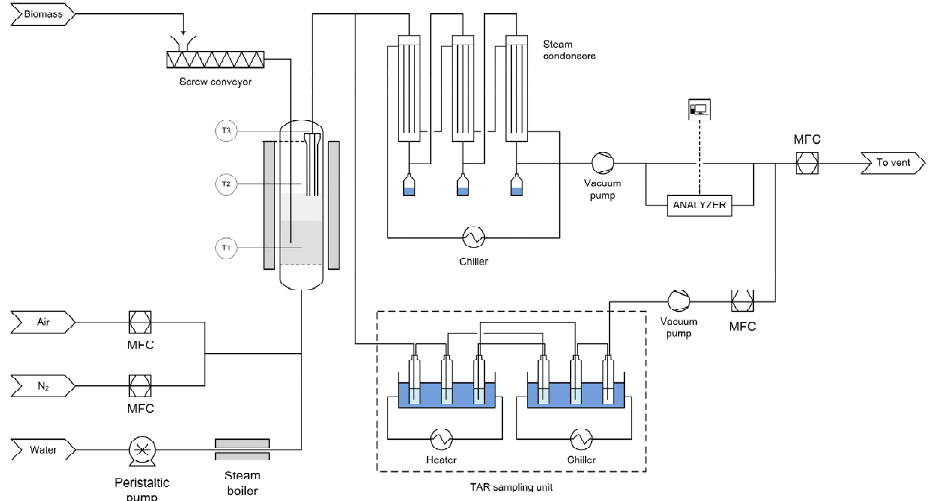
Figure 2. Simplified scheme of the bench-scale gasification test rig. Biomass particles are fed from the top of the reactor by means of a screw-feeder operating at a constant feeding rate. Steam and nitrogen were fed from the bottom of the reactor percolating through a porous ceramic plate. The demineralized water is fed with a peristaltic pump to the electric steam generator at the defined flow rate. The flow rate of nitrogen was controlled by a mass flow controller (Bronkhorst ®